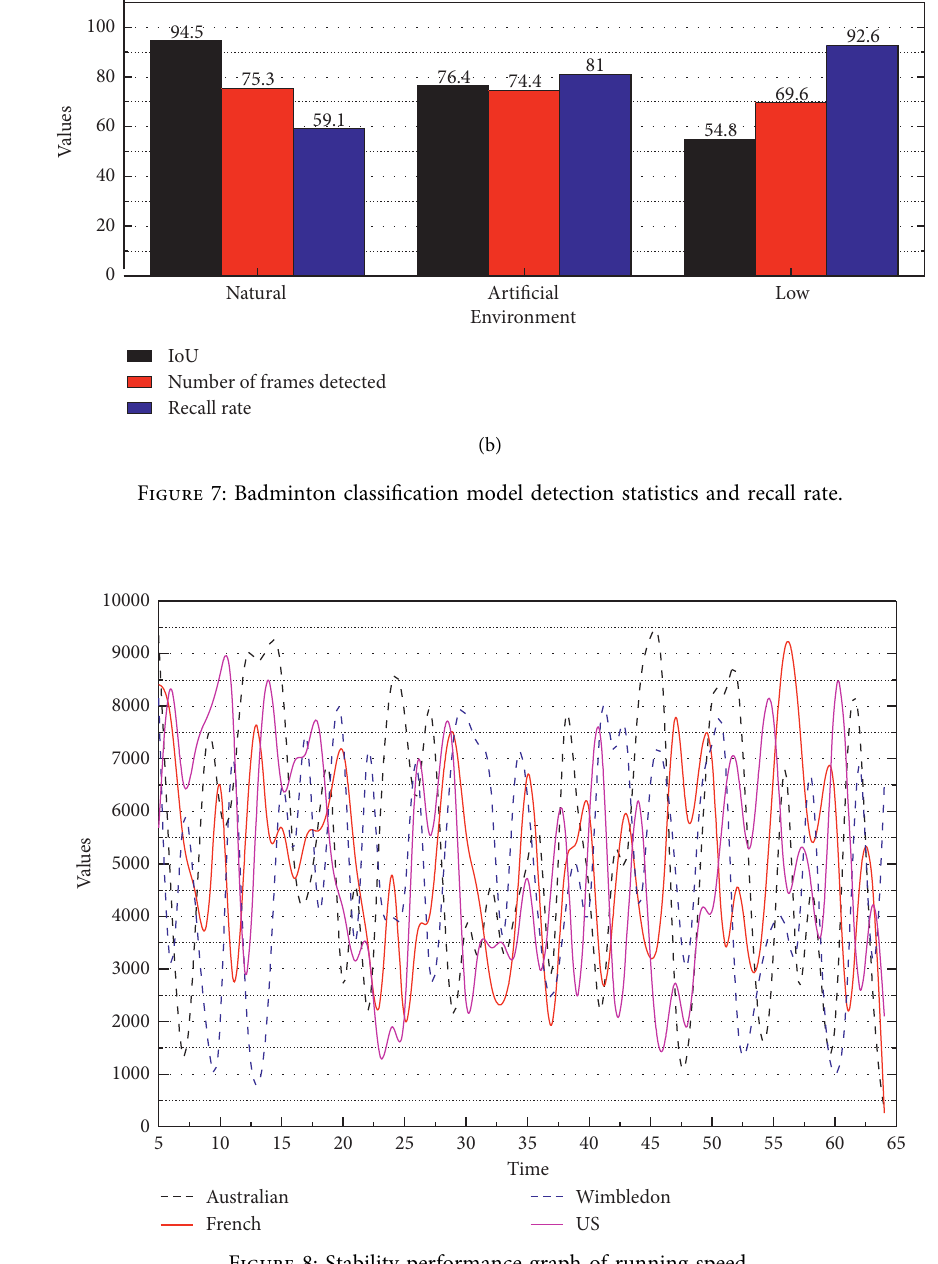
Figure 8: Stability performance graph of running